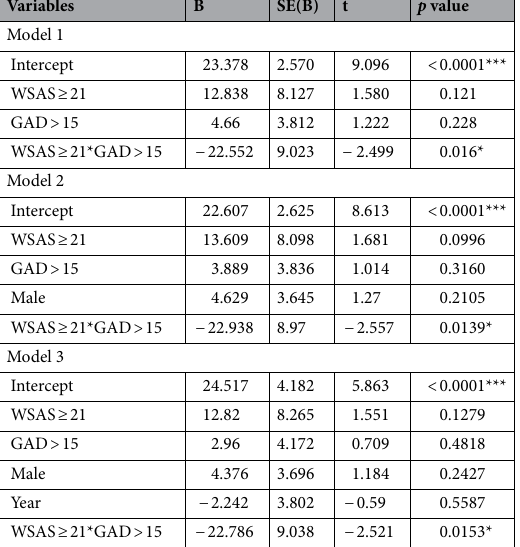
Table 1. Results of linear regression models for students with high levels of anxiety and functional impairment as dependent variables. WSAS ≥ 21*GAD > 15: interaction between WSAS ≥ 21 scores and GAD > 15 scores. Statistics: Estimated (B), Standard Error (SE), t value (t) and p value ( p ) are shown across the table (0; ‘***’0.001; ‘**’0.01; ‘*’0.05; ‘0.1’; ‘1’). Model 1: R 2 = 0.1594; adjusted R 2 : 0.10. Model 2: R 2 =